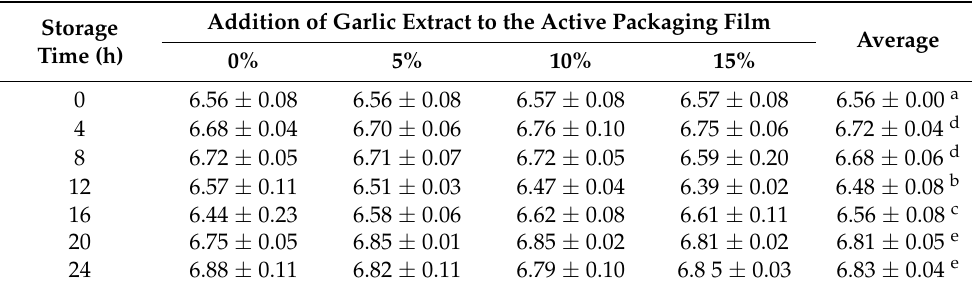
Table 1. pH values of packaged meat sample stored at room temperature for 24